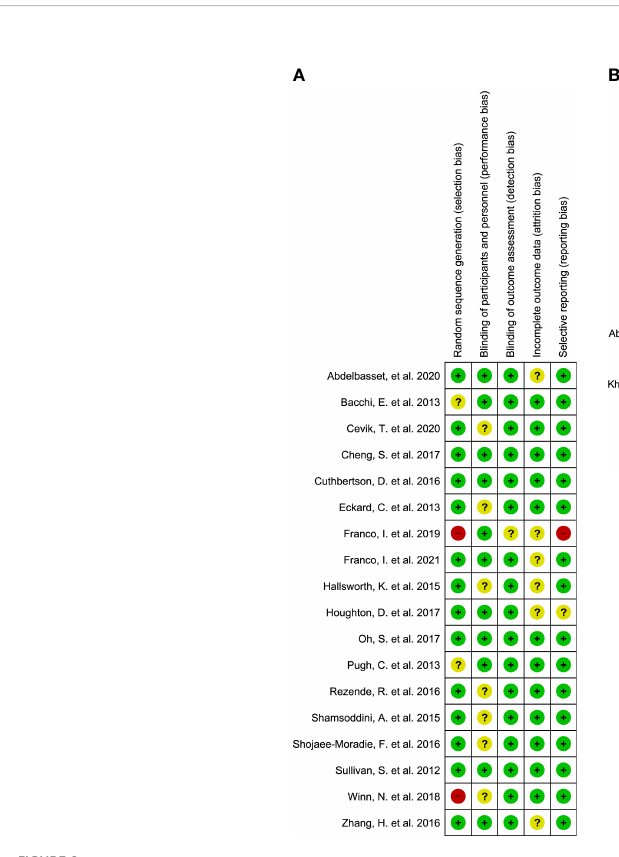
FIGURE 9 The results of the quality assessment of (A) randomized controlled trials (RCTs); (B) non-randomized controlled trials